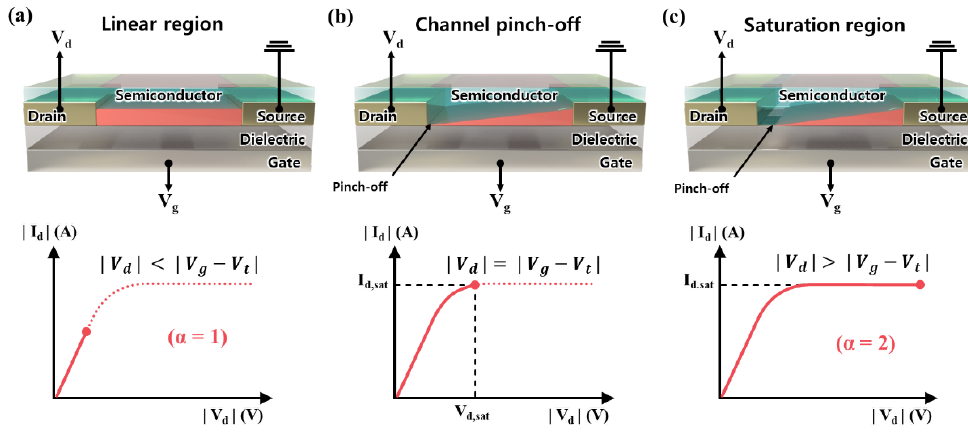
Figure 3. The α -regime in OFET corresponding to ( I d , V d ) characteristics. (( a ) Linear regime ( α = 1 ) , -regime in OFET corresponding to ( Figure 3. The ( b ) Channel pinch-off, and ( c ) Saturation regime ( α = 2 ) 𝛼𝛼 1)